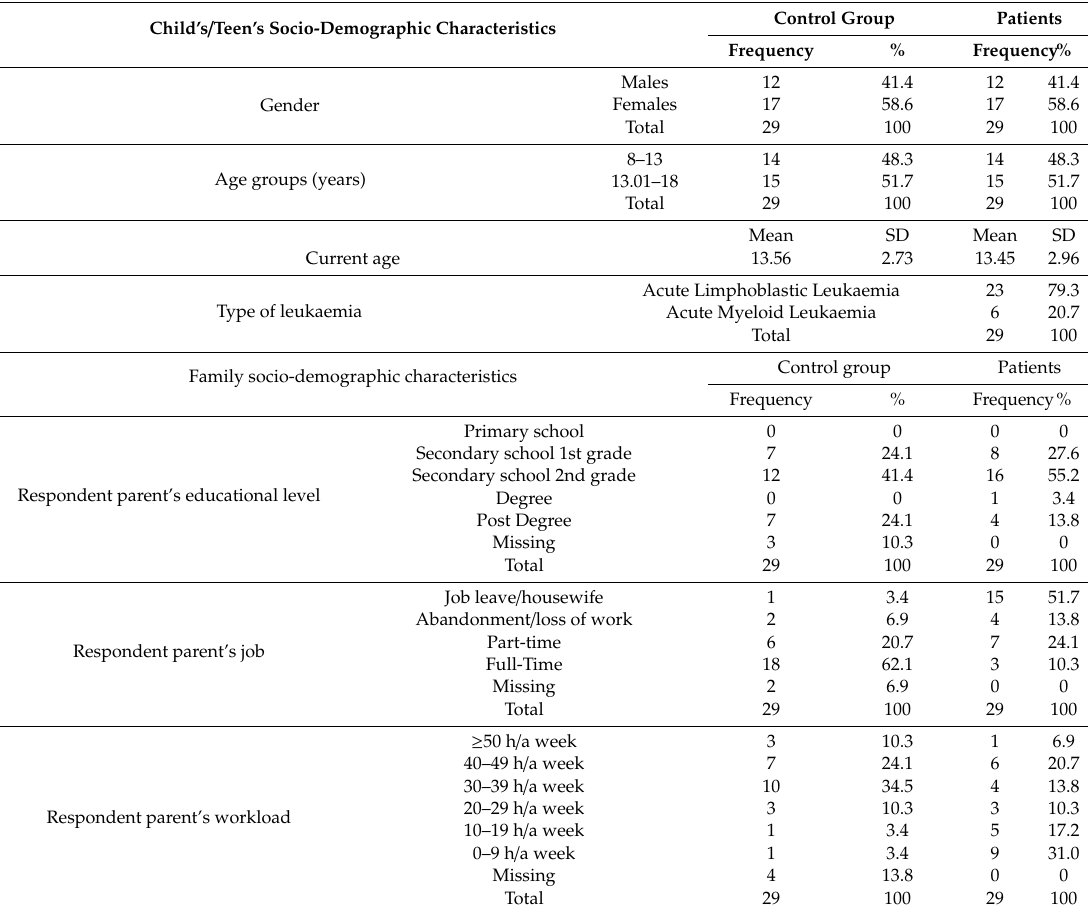
Table 2. Socio-demographic characteristics of patients / families and healthy controls / families at 12 months